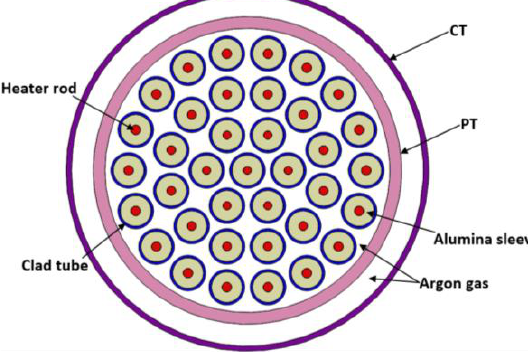
Figure 2: Cross-sectional view of the